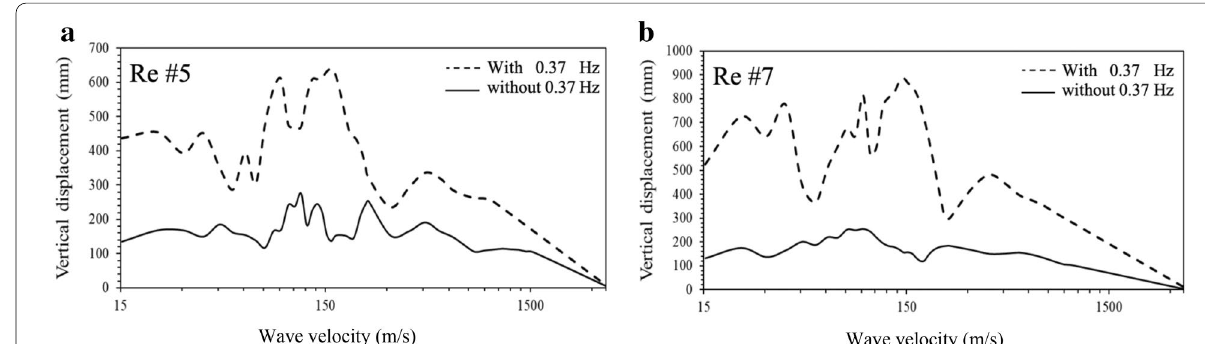
Fig. 10 Deck vertical displacements w/o the frequency content of 0.37 Hz: a Record #5, b Record #7.